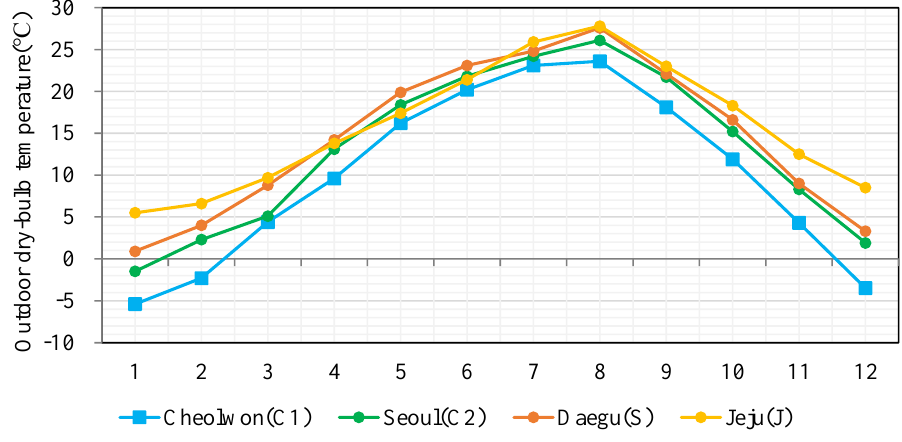
Figure 4. The monthly average ambient temperature of each city.